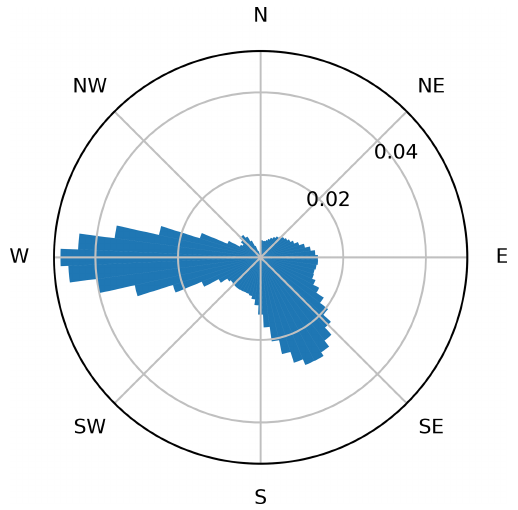
Figure 11. The full wind rose used for the optimizations in this study. The wind rose is divided into 72 bins with dominant wind directions from due west and from